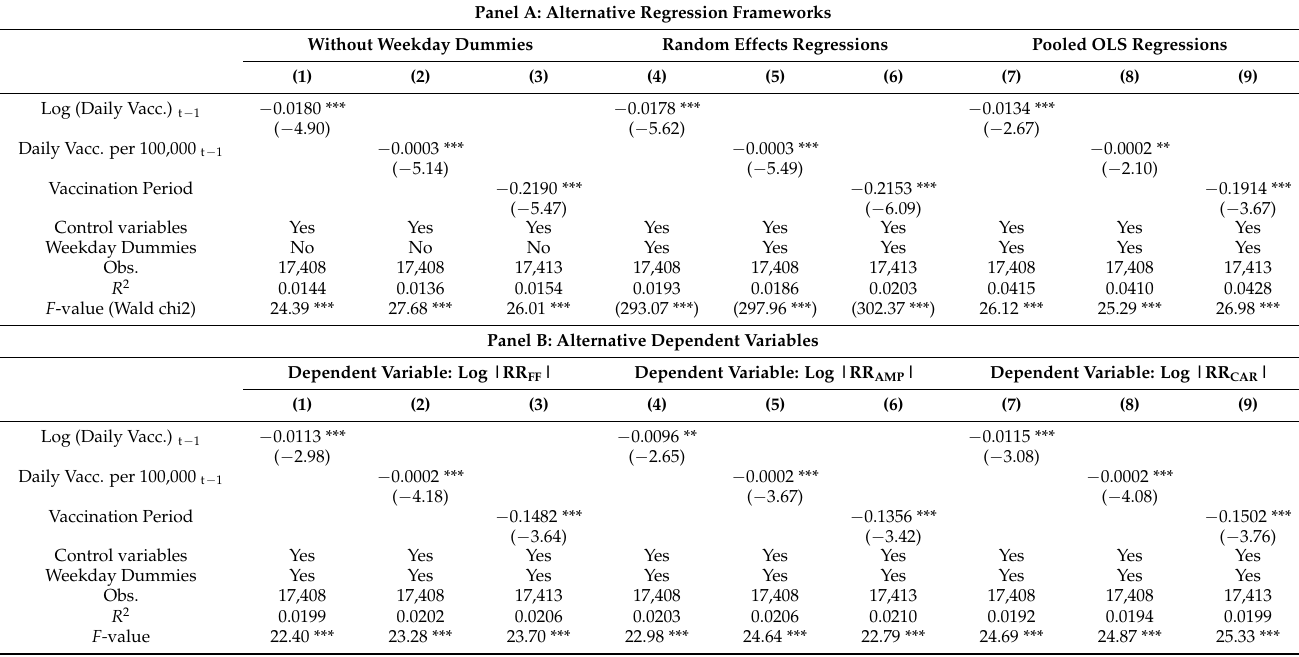
Table 5. Robustness tests: modified regressions and alternative variables. Panel A: Alternative Regression